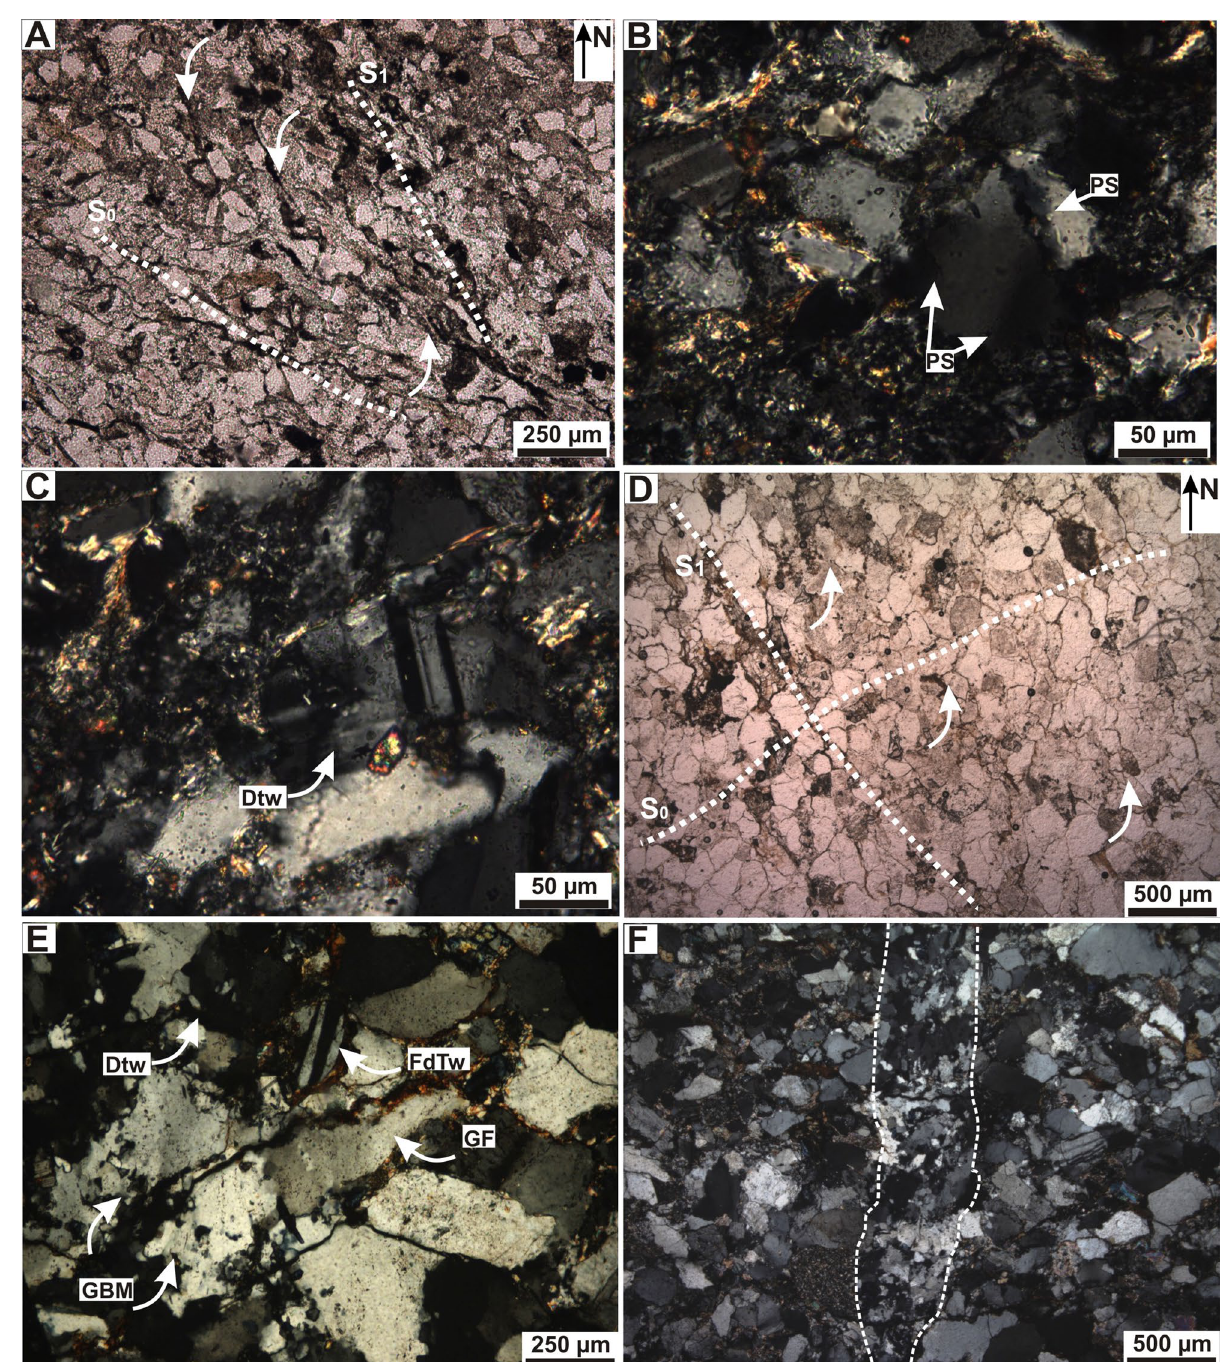
Figure 4. Micro-photograph of the Bonete Formation: ( A ) Primary foliation S 0 evidenced by flattening of the quartz and feldspar grains in microlithons, micas and opaque minerals in cleavage domains; second foliation S 1 defined by planes of fluid migration, opaque minerals and micas presence; under transmitted light with parallel nicols. ( B ) Pressure shadows (PS) and subgrains in quartz and feldspar, ( C ) Deformed twins (Dtw). Micro- photograph of the Tunas Formation: ( D ) Primary foliation S 0 orientated N45°; second foliation S 1 orientated N20°, defined by planes of fluid migration, micas and opaque; under transmitted light with parallel nicols. ( E ) Grain flattening (GF), deformed feldspar twinning (FdTw) and grain boundary migration (GBM) inside grains under, transmitted light with crossed nicols. ( F ) Vein development with strong grain boundary migration in quartz forming mineral cement phase, under transmitted light with crossed